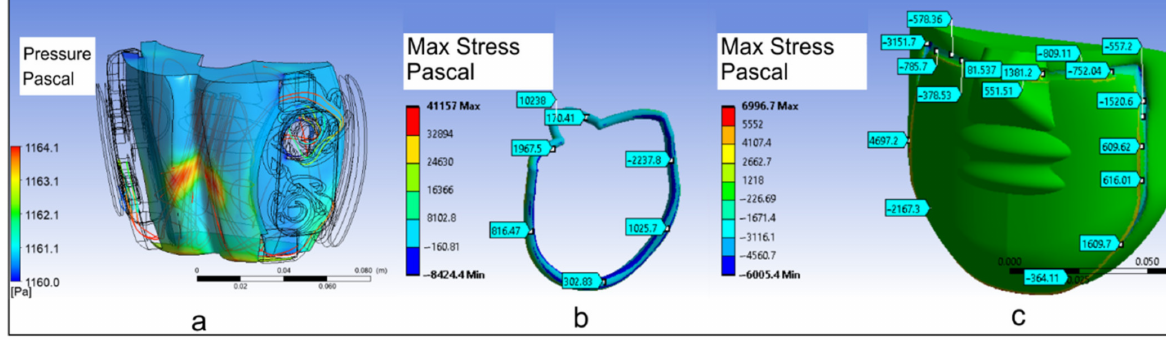
Figure 13. Contours of pressure and stress derived from the structural analysis. ( a ) Pressure contour from aerodynamic analysis; ( b ) stress over the mask seal; ( c ) stress over the contact area of the seal over the